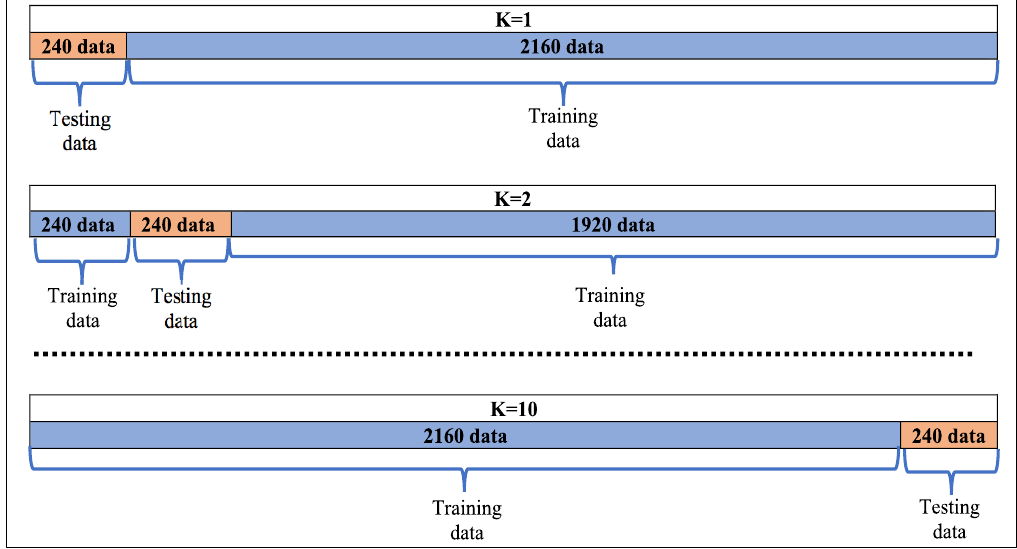
Figure 8. Illustration of the validation process using K-Fold